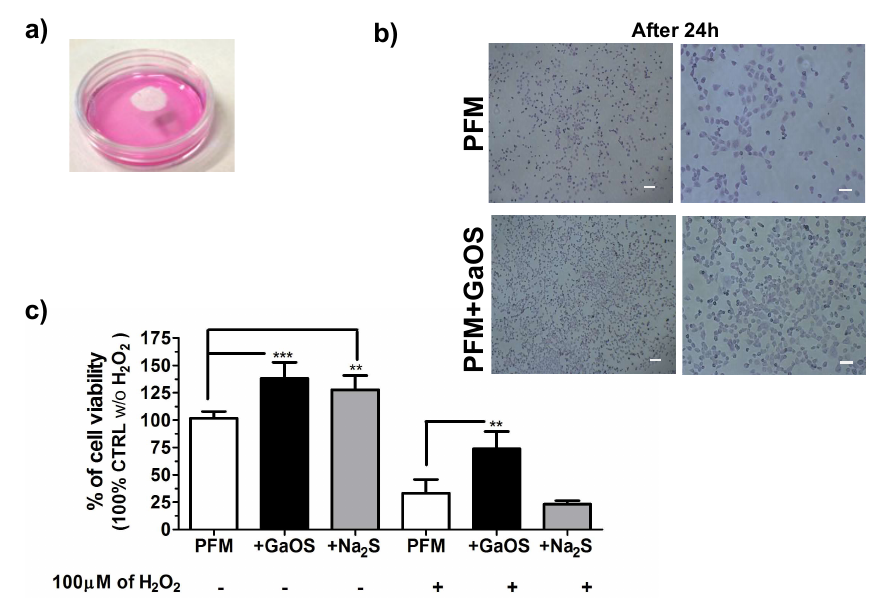
Figure 5. Effect of gaseous release from PFM+GaOS on 2D-culture of cMSC. ( a ) Photo-optical image of PFM+GaOS on the lids of the petri dishes where 1 × 10 4 cells/cm 2 were seeded; ( b ) pptical micrographs of cMSC after 24 h of cell growth in the presence of PFM+GaOS disk (1 cm of diameter) on the petri dishes-lid and stained with crystal violet; ( c ) cell viability of cMSC cultures in the presence or in the absence of 100 μM H 2 O 2 with PFM, PFM+GaOS, or PFM + Na 2 S on the petri dishes-lids. ** p < 0.02; *** p < 0.005